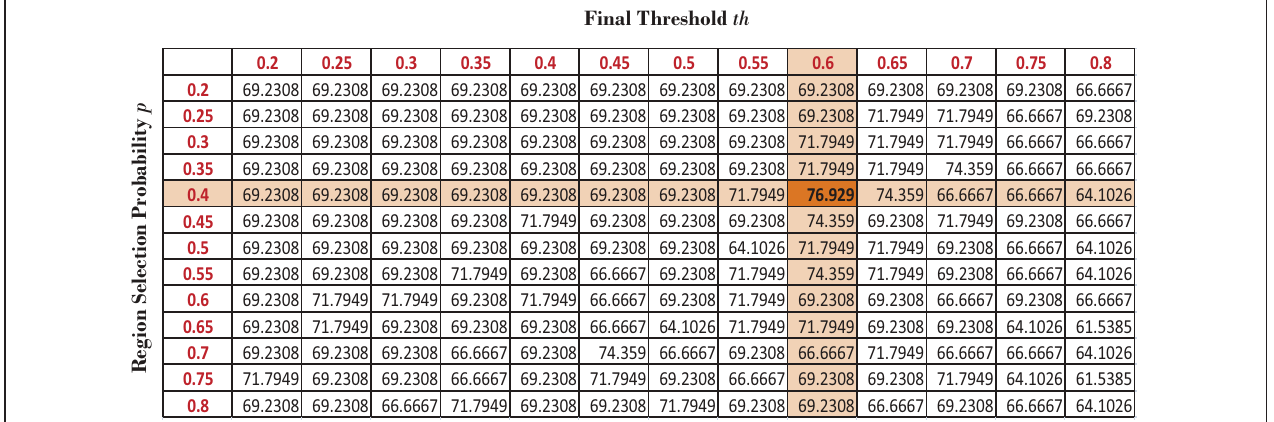
FIGURE A1 | Different detection results on KKI data set based on different set of values of p and th .